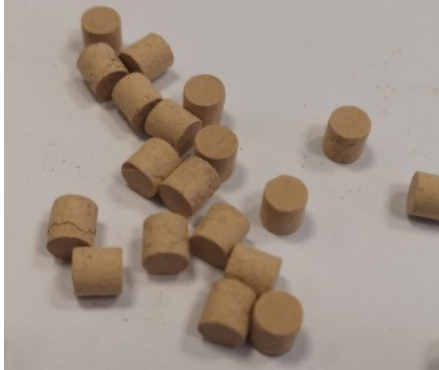
Figure 12. Fe-Clin-I shaped into pellets.